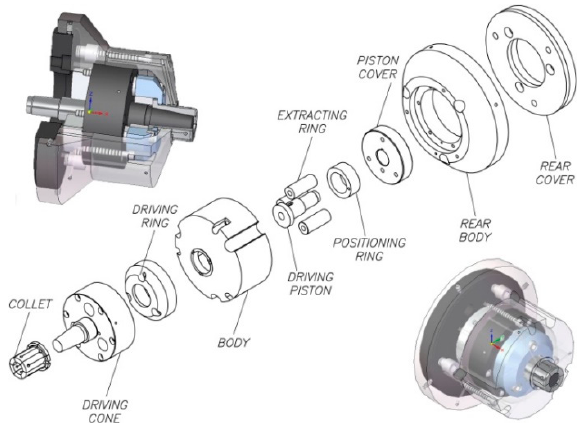
Figure 2. Automatic expanding mandrel design.